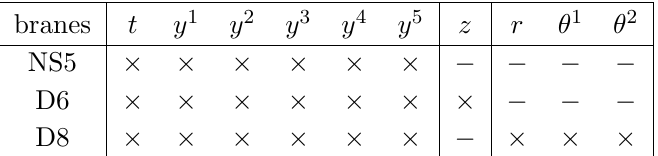
Table 1 . The brane picture underlying the 6d (1 ; 0) SCFT described by a NS5 { D6 { D8 system. The above system is 1 { BPS. Note that the radial coordinate realizing the dual AdS 7 geometry 4 turns out to be a combination of z & r .